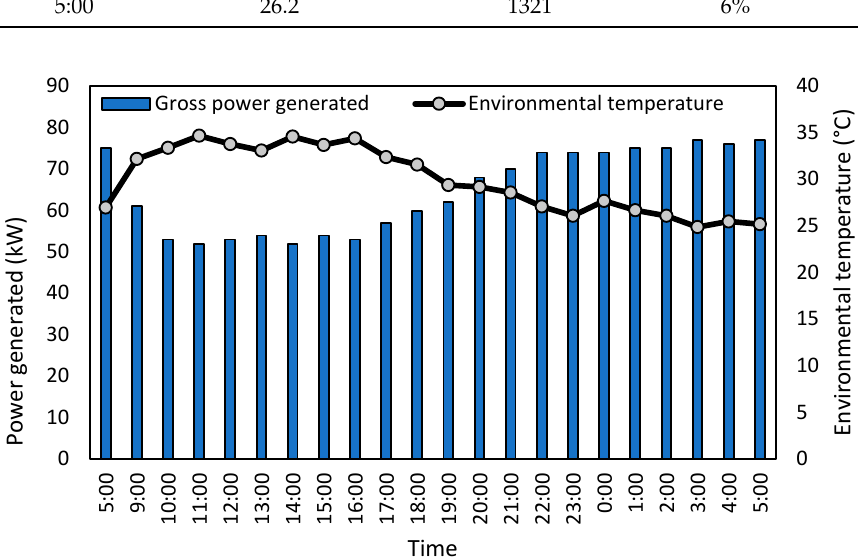
Figure 6. 24 h production of the ORC system in one of the subject oil fields.